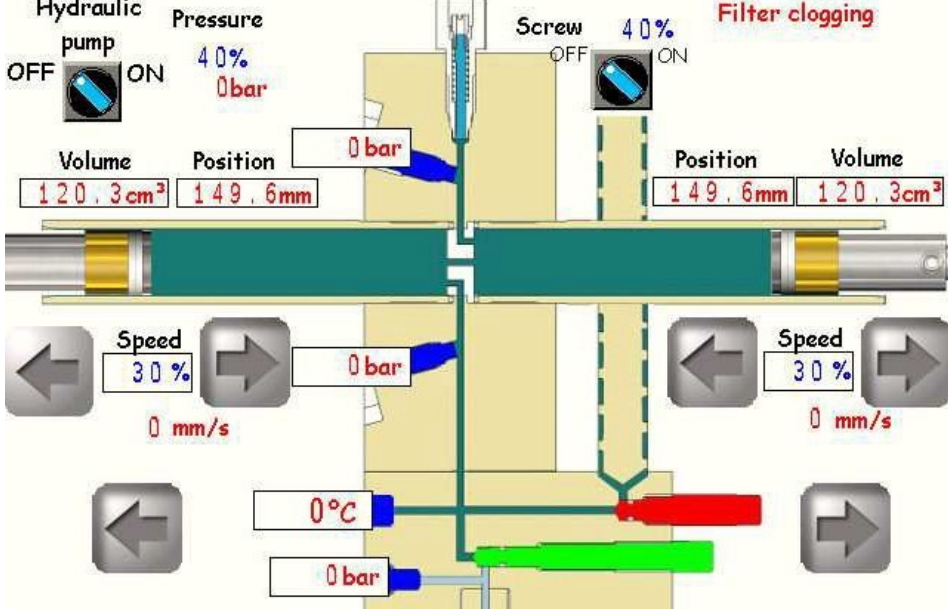
Figure 2. Shematic principle of RMX [31].